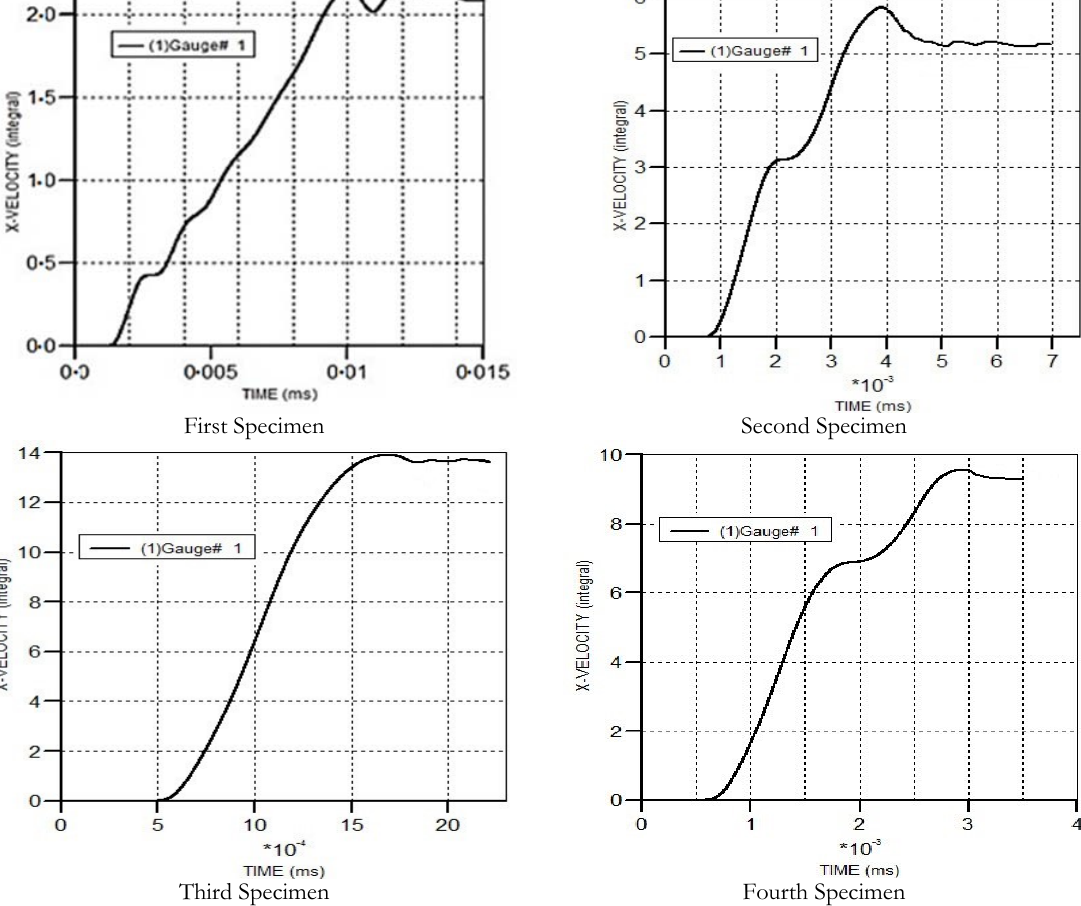
Figure 18: Diagram of the specimen’s center